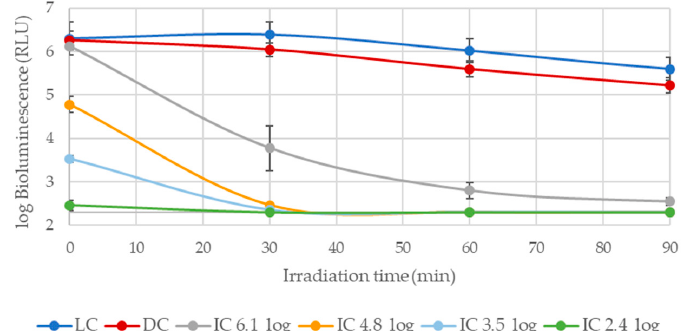
Figure 2. E. coli inactivation in sterilized WW at different initial bacteria abundances. Tetra-Py + -Me was used at a concentration of 10 µM and the samples were irradiated with artificial PAR white light (380–700 nm) at an irradiance of 40 W m − 2 for 90 min. Legend: light control (LC), dark control (DC), and different initial bacterial abundances (IC). Values represent the mean of three independent experiments with two replicates each. XX axis cross the YY axis at 2.30 log RLU, representing the detection limit of the method.